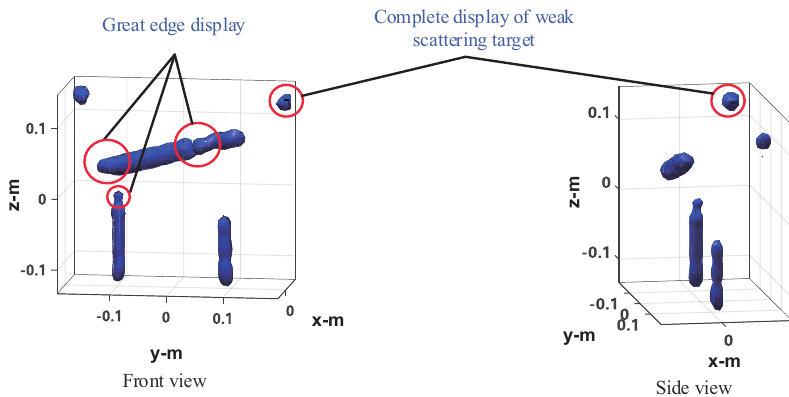
Figure 18. Imaging results of the proposed